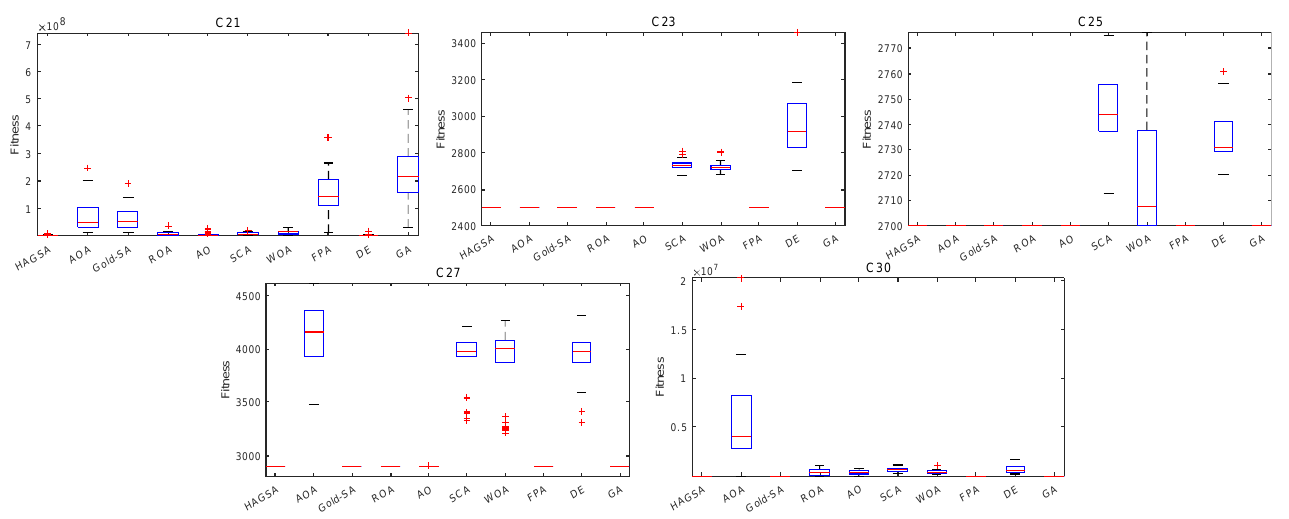
Figure 8. Boxplot behavior of algorithms on some functions.